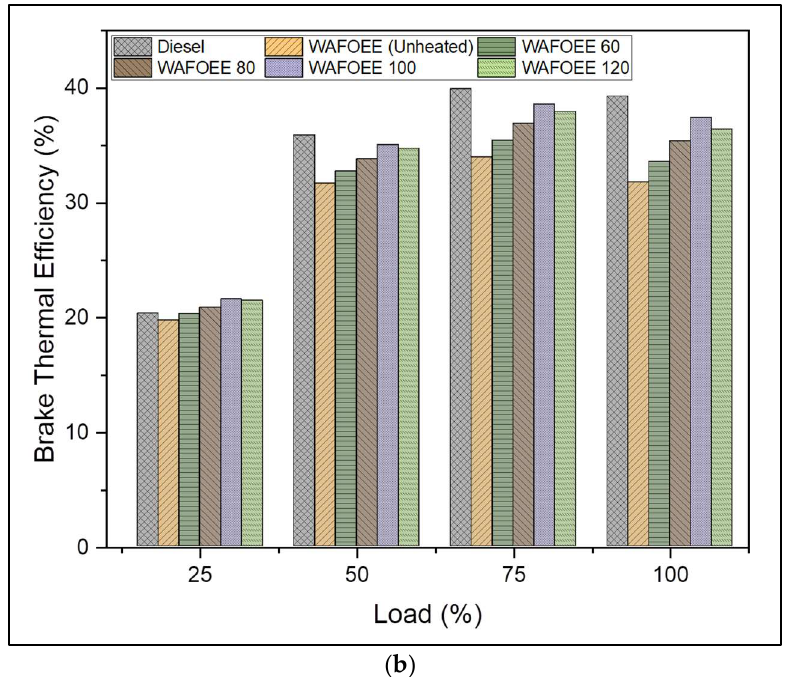
Figure 9. ( a ) Specific fuel consumption of neat diesel and biodiesel samples for varying engine loads. ( b ) Brake thermal efficiency of neat diesel and biodiesel samples for varying engine loads.